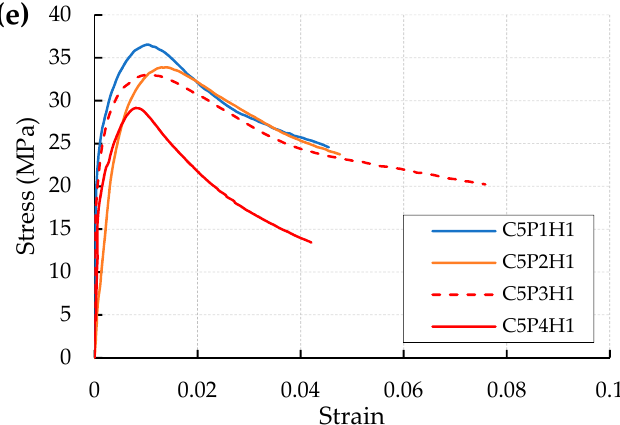
Figure 15. Stress-Strain curve of different uPVC tube size confined concrete cylinder for: ( a ) C15, ( b ) C20, ( c ) C25, ( d ) C30, and ( e ) C35.